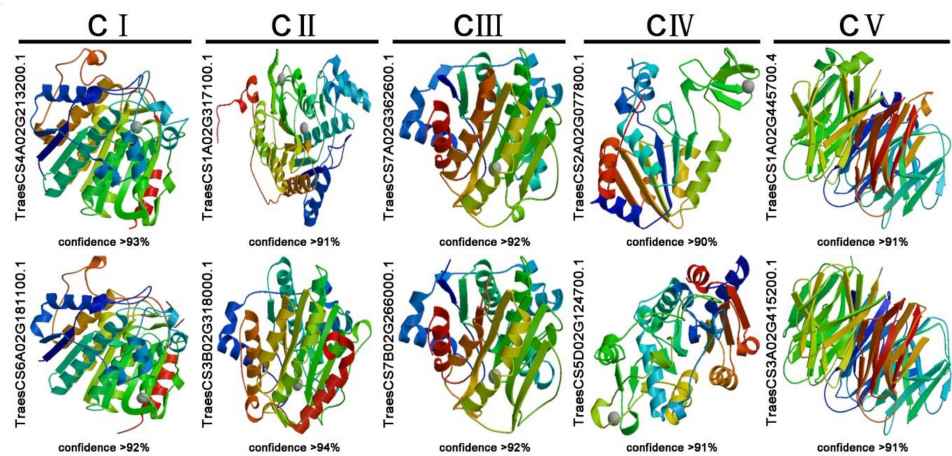
Figure 3. Prediction of the spatial structure of TaHDACs. The 10 TaHDACs with high confidence (greater than 90%) were